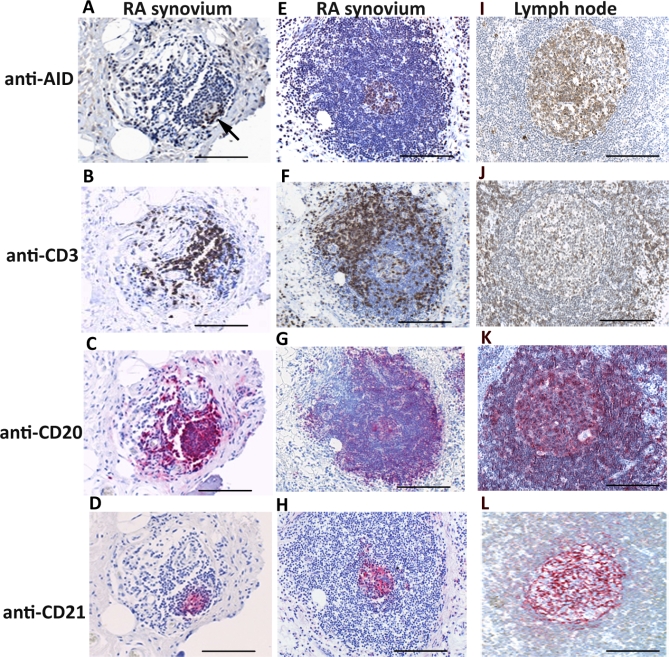
AID Expression within the Rheumatoid Synovial Membrane Is Restricted to Lymphoid Aggregates with FDC NetworksA representative example of sequential paraffin-embedded sections of LN and RA synovial membrane stained for AID (brown, A, E, I), T cells (CD3, brown, B, F, J), B cells (CD20, red, C,G, K) and follicular DCs (CD21, red, D,H, L). The presence of FDC networks was invariably associated with the expression of AID even in FDC+ grade 3 aggregates (arrow, A), without morphologically detectable dark and light zones within the B cell rich area (A−D). In more organised grade 3 aggregates (E−H), expression was more prominent and closely resembled that seen in secondary lymphoid organs, such as the LN (I−L) (original magnification was 20×). Scale bars 200 μm.